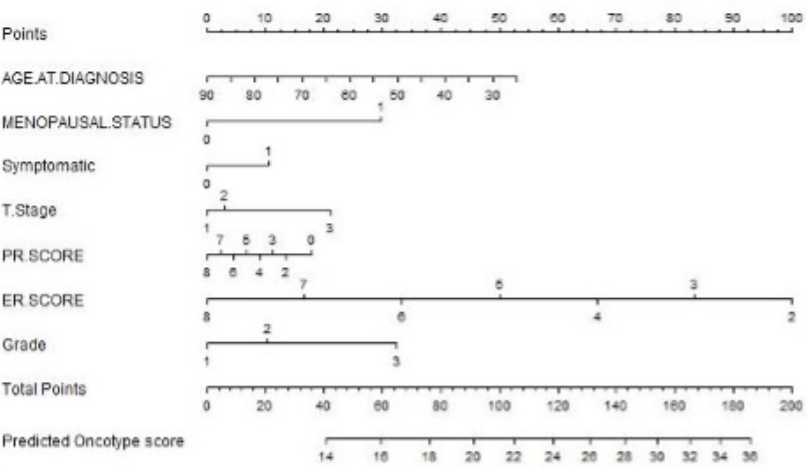
Figure 3. Static nomogram model capable of predicting a ‘surrogate’ recurrence score as a continu ‐ ous variable. ous